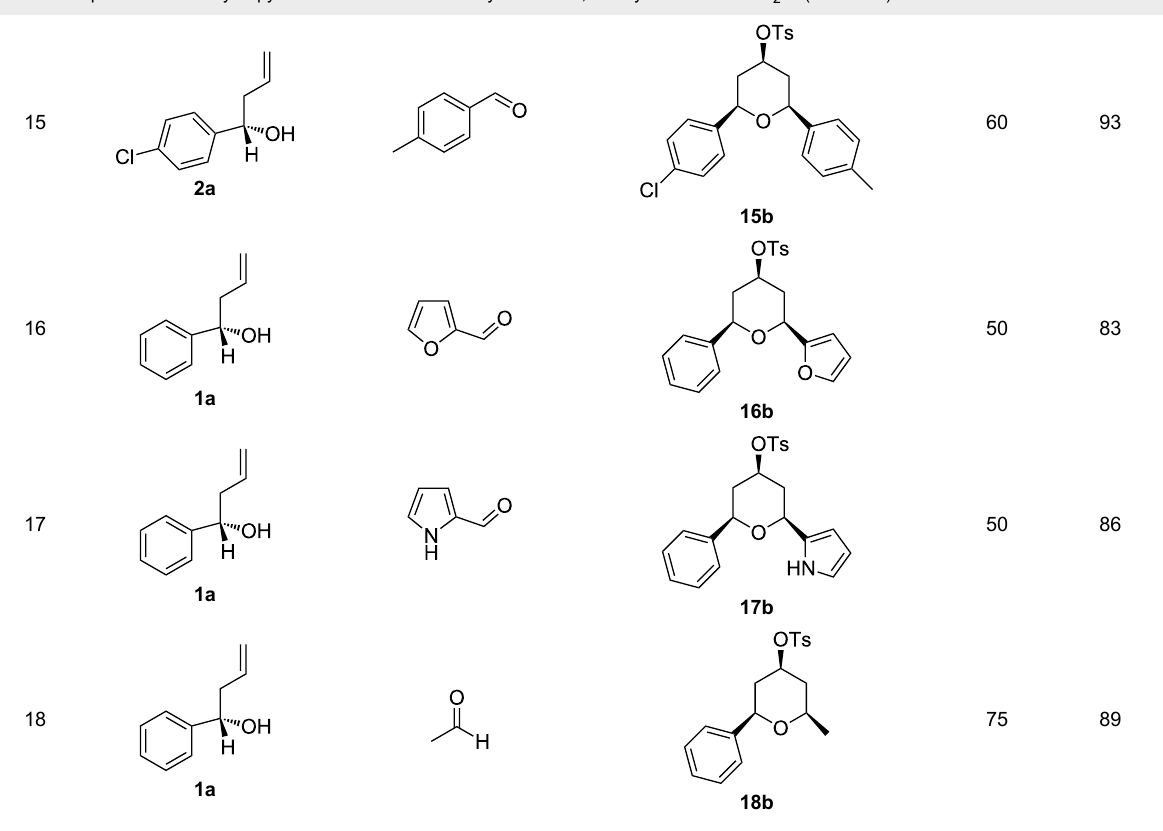
Table 2: Preparation of tetrahydropyrans from aromatic homoallylic alcohols, aldehydes and PTSA·H 2 O.